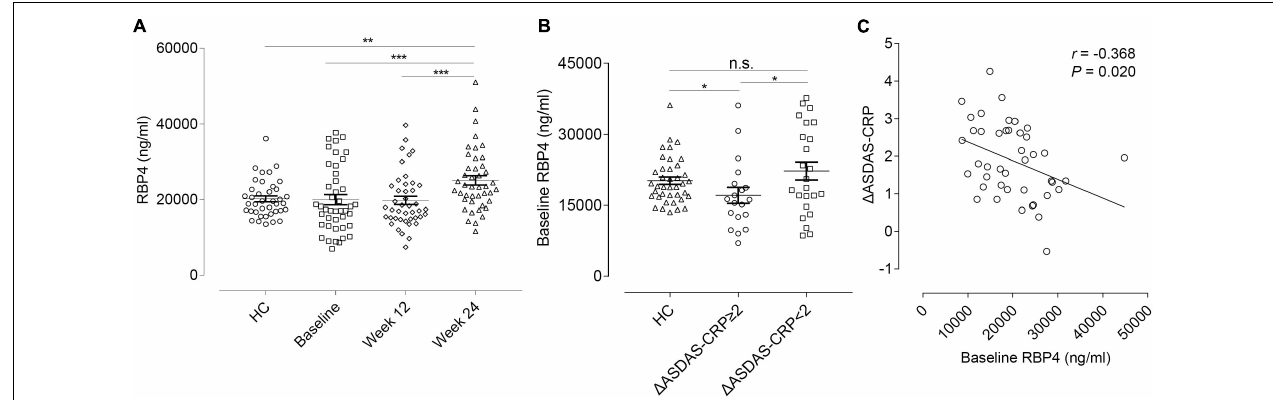
FIGURE 4 | RBP4 expression levels and the correlation with (cid:49) ASDAS-CRP in the validation cohort. (A) Relative serum RBP4 expression levels between HCs and AS patients at baseline, week 12, and week 24. Data were shown as scatter plots (mean ± SEM). (B) Relative baseline RBP4 expression levels in HCs and in AS patients with and without major improvement in ASDAS-CRP ( (cid:49) ASDAS-CRP ≥ 2 and (cid:49) ASDAS-CRP < 2) at week 24. Data were shown as scatter plots (mean ± SEM). (C) Linear correlation between baseline RBP4 levels and (cid:49) ASDAS-CRP at week 24. * P -value < 0.05, ** P -value < 0.01, *** P -value < 0.001. (cid:49) ASDAS-CRP, improvements of Ankylosing Spondylitis Disease Activity Score-C-Reactive Protein; HC, healthy control; AS, ankylosing spondylitis; n.s., not significant.